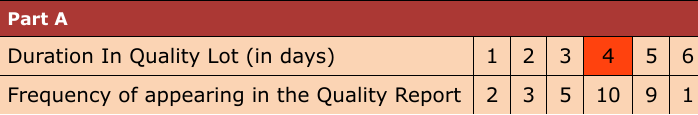
Table 7. Duration in Quality Lot (Days)